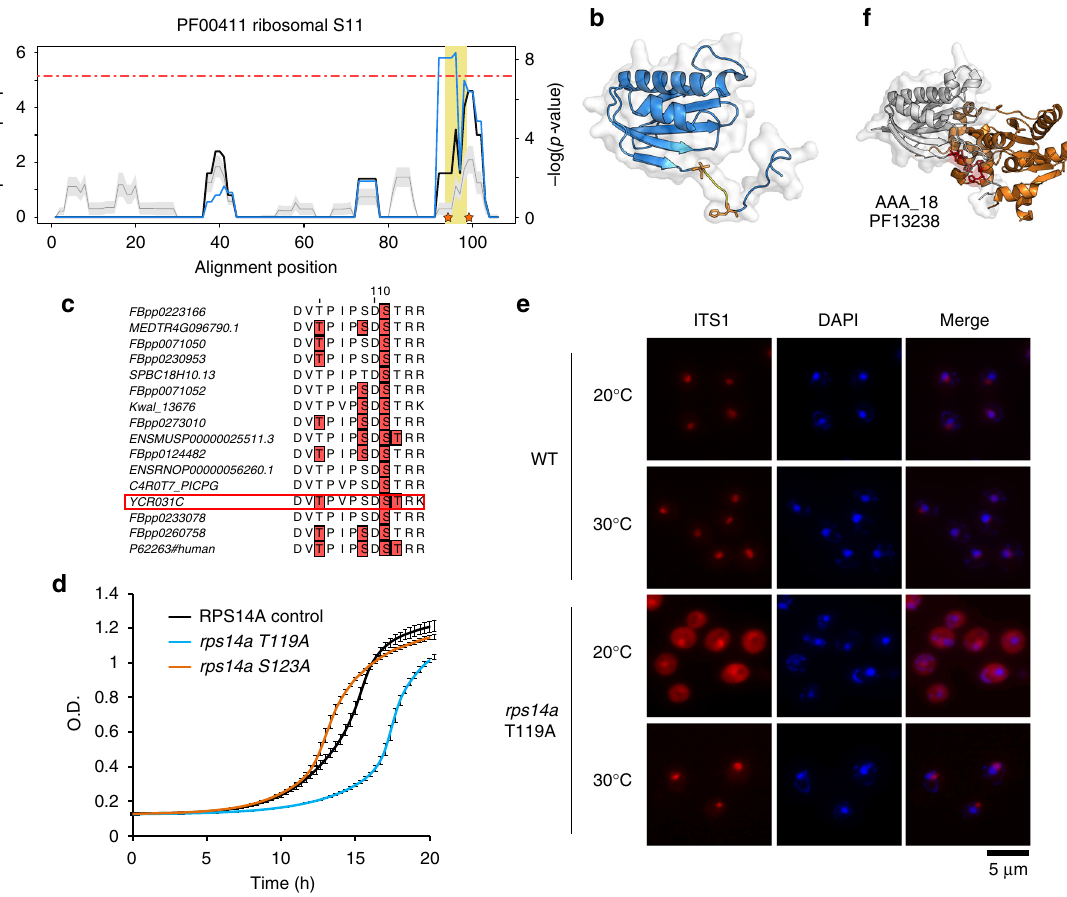
Fig. 6 Rps14a T119A mutant shows growth and 20S processing defects in cold shock. a The phosphorylation enrichment over random for the ribosomal S11 domain (PFAM:PF00411) is plotted in a solid black line. The background expectation is shown in gray line, with standard deviations as gray band. The blue line represents the negative logarithm of p -value ( Y axis on the right side). A horizontal red line indicates a cut-off equivalent to a Bonferroni corrected p - value of 0.05. Mutated residues in Rps14a (T119 and S123) are indicated by orange stars in the plot and shown in b as orange stick representations (PDB:5wnt_K). c Conservation of phosphorylation sites in this region across species. d Growth curve for Rps14a T119A and S123A mutants in 25 °C in SC media. Source data are provided as a Source Data fi le. e In situ hybridization with a Cy3-labeled oligonucleotide complementary to the 5 ′ sequence portion of ITS1 was assayed in 30 and 20 °C. f Structural representation of contacts between the hotspot region of Rps14a (represented in gray) and the ATPase domain of Fap7 (represented in